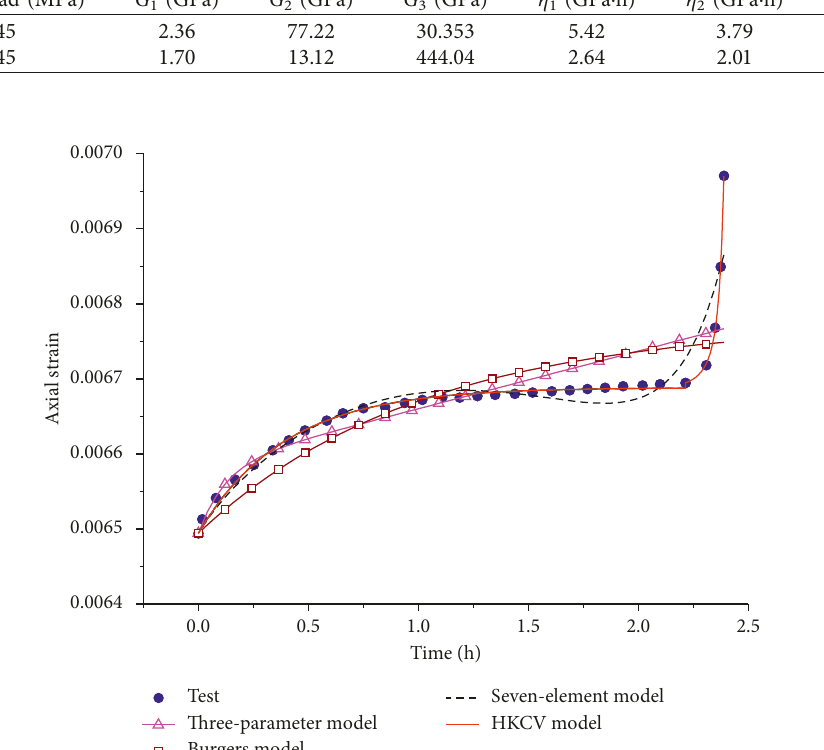
Figure 8: Comparison between test value and model values (under dry condition, σ